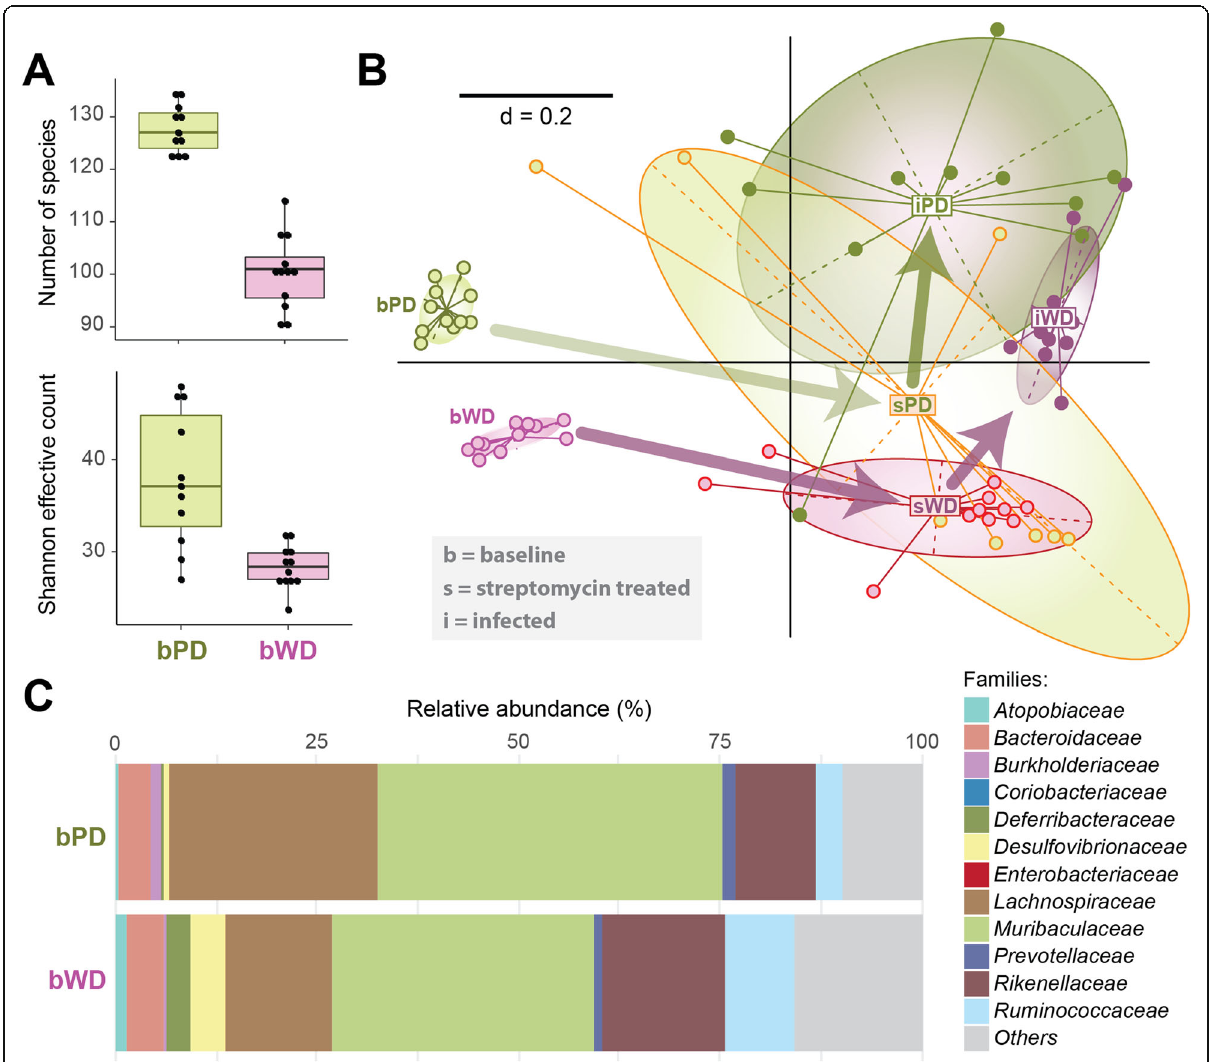
Fig. 1 Differences in the fecal microbiota diversity and composition in to dietary mice groups. a Changes in α -diversity are shown as boxplots. All differences between two samples are significant (p ≤ 0.05) according to the pairwise Wilcoxon Rank Sum Test (n of WD fed mice = 12, n of PD fed mice = 11). b β -diversity analysis displayed as a nonmetric multidimensional scaling plot (metaNMDS) computed from generalized UniFrac distances, which were calculated from normalized OTU tables and phylogenetic distance trees (n of WD fed, untreated mice = 12, n of WD fed, streptomycin-treated/infected mice = 11, n of PD fed, untreated/infected mice = 11, n of PD fed, streptomycin-treated mice = 8). c An overview of relative abundances of major bacterial families is given by stacked bar plots. Cumulative abundances were calculated from all single OTUs classified within one family as per the best possible taxonomy using both the RDP and Silva. N of WD fed mice = 12, n of PD fed mice =